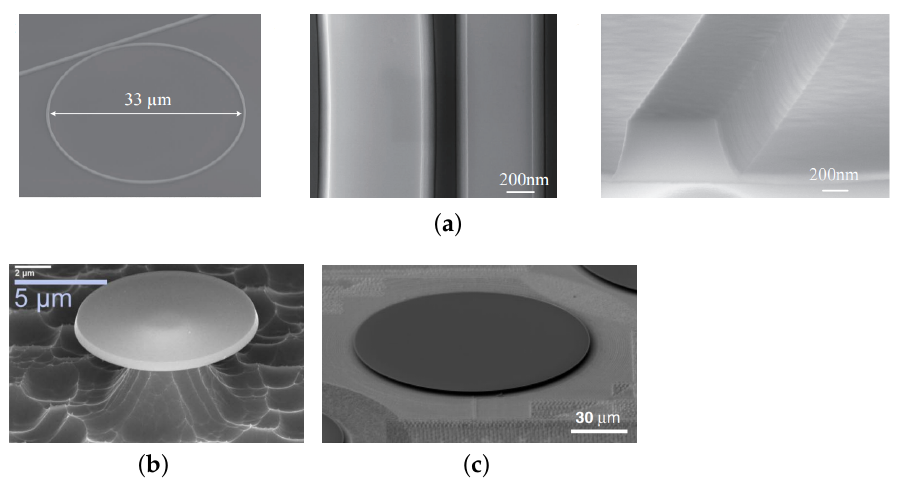
Figure 3. Scanning electron microscope images of ( a ) 4H SiCOI MMR, reprinted with permission from [36] ©The Optical Society, ( b ) 3C SiC MDR [59], and ( c ) 4H SiCOI MDR